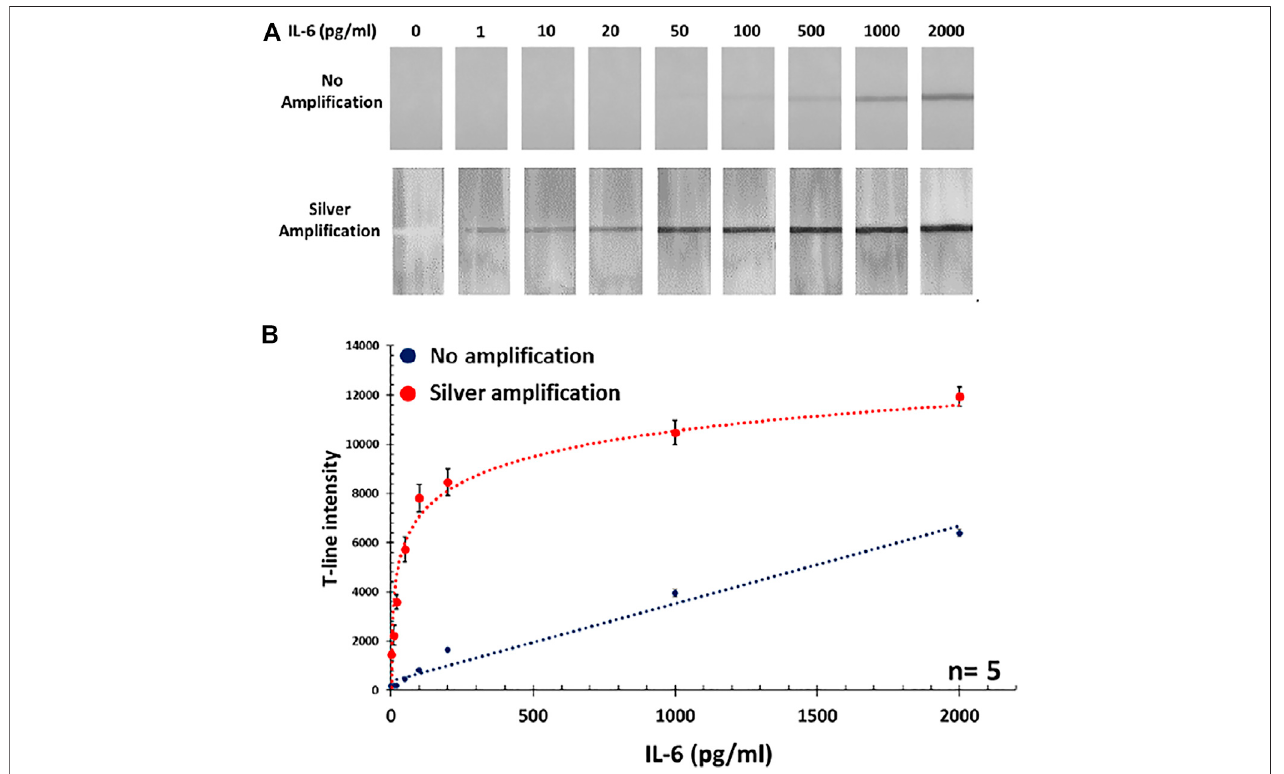
FIGURE2|(A) PhotographsofpaperstripsshowingtheintensityofobtainedT-linesafterandbeforeampli fi cationstep. (B) Thecorrespondingcalibrationcurvefor IL-6 detection in PBS with and without silver ampli fi